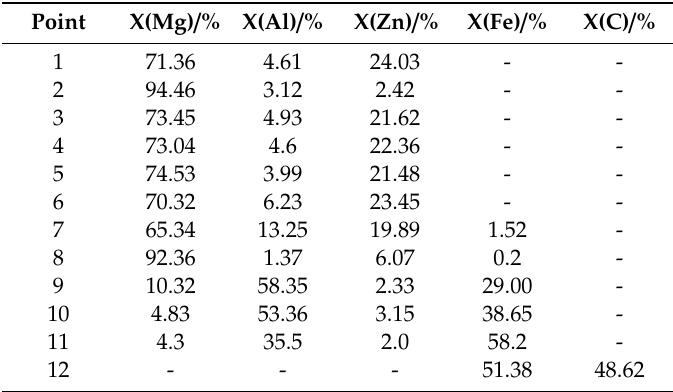
Table 3. Compositions of points 1 to 12 in Figure 7 by EDS